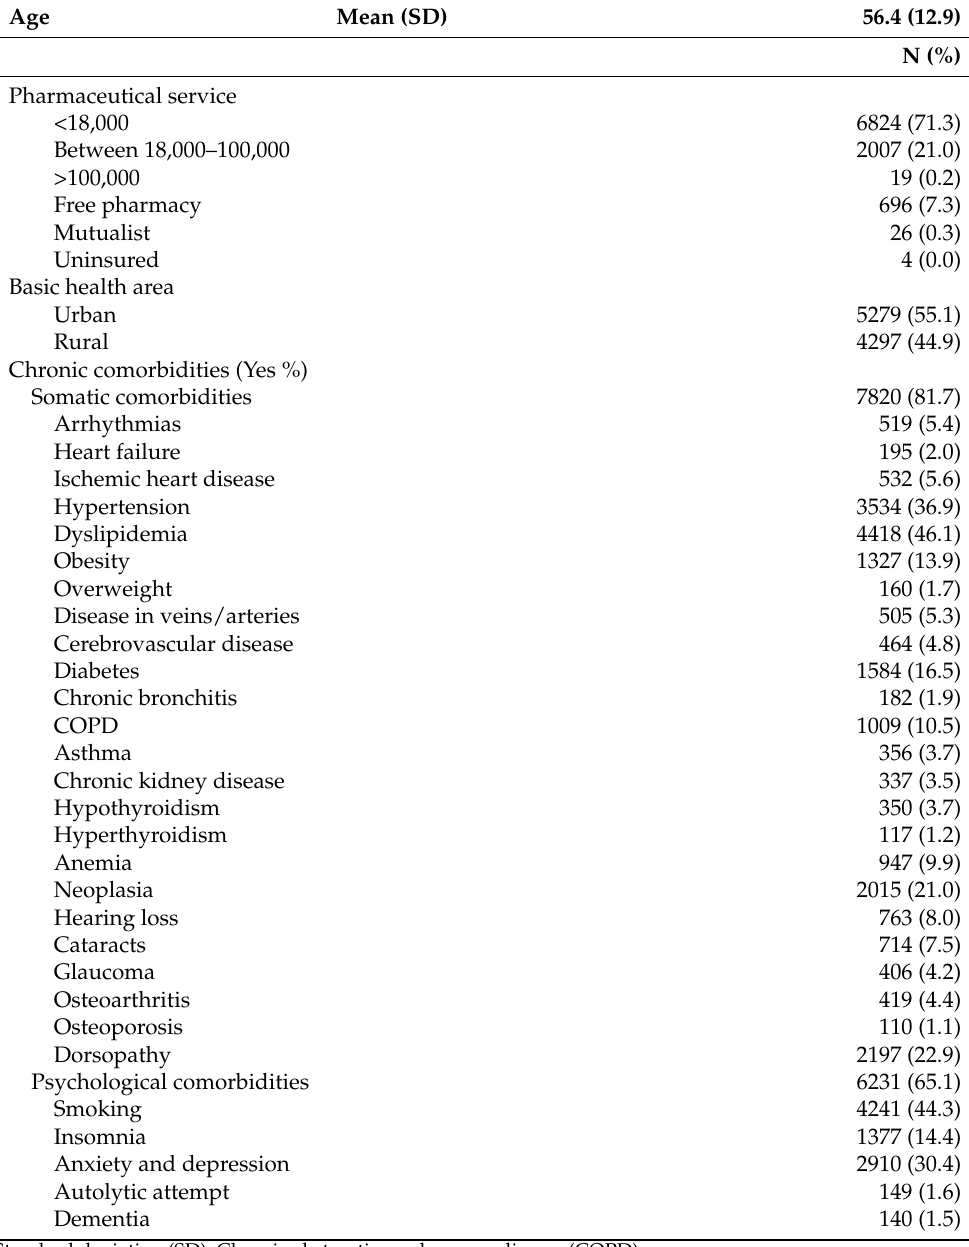
Table 1. Sociodemographic data and chronic comorbidities in alcohol abuse disorder patients from